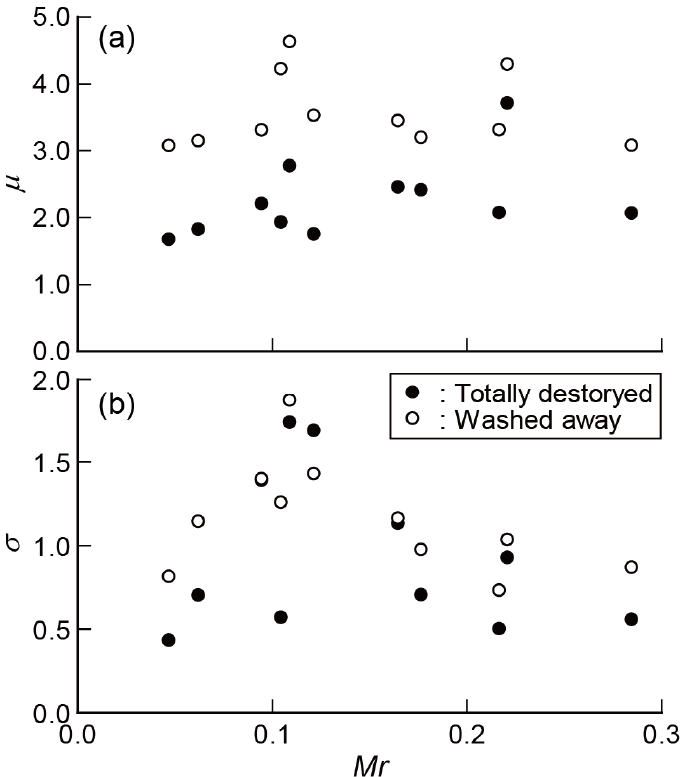
Figure 11. Relationships between the proportion of robust buildings Mr and coefficients ( a ) µ and ( b ) σ .